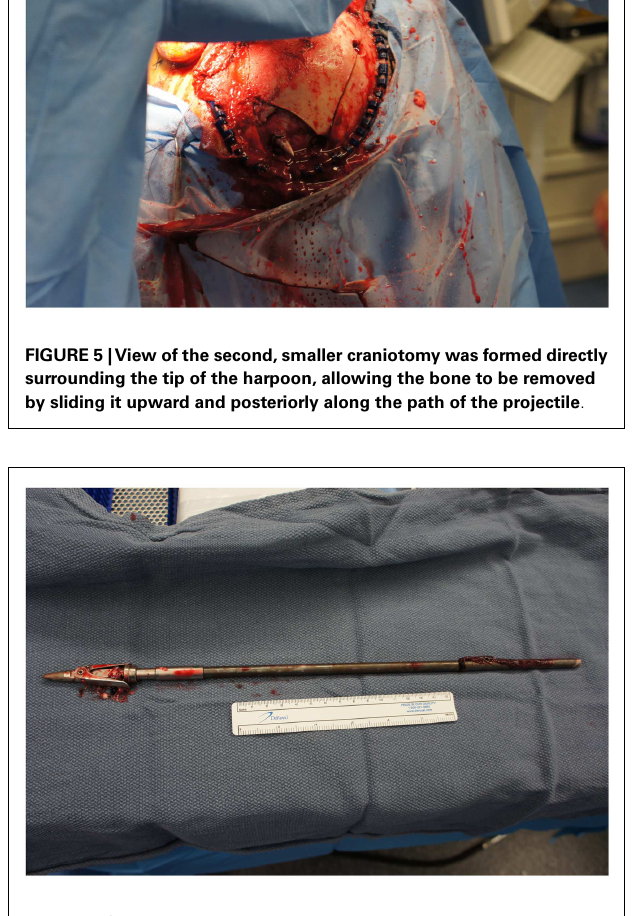
FIGURE 6 |The embedded portion of the spear after removal .